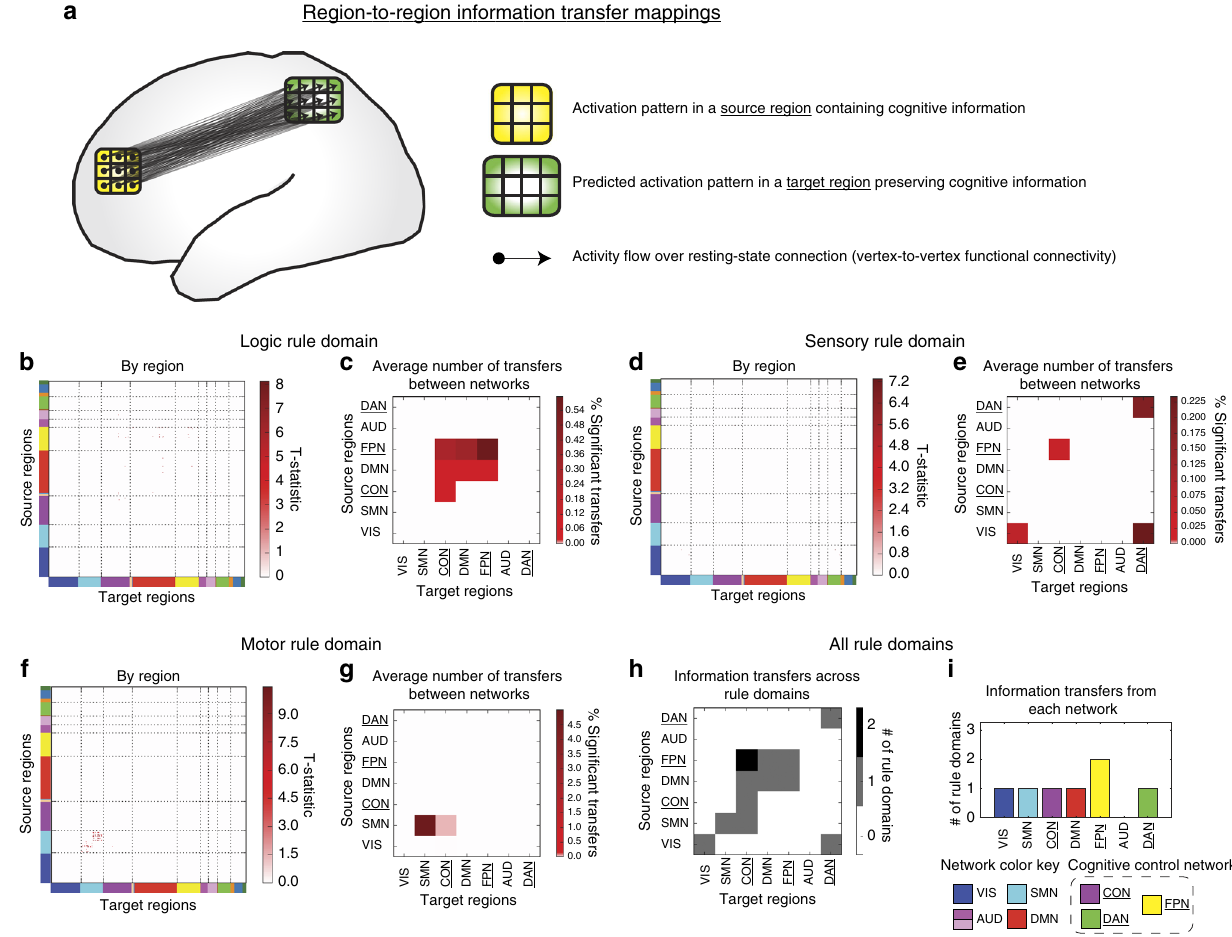
Fig. 6 Information transfer mappings between all pairs of regions. All reported results were statistically signi fi cant at p < 0.05 (FWE-corrected) (see Supplementary Fig. 6 for results with an FDR-corrected p < 0.05 threshold). a Region-to-region information transfer mapping used the vertex-level activation pattern within one brain region and the fi ne-grained region-to-region resting-state FC topology to predict the vertex-level activation pattern in another brain region. b Logic rule region-to-region information transfer mapping. c Average number of statistically signi fi cant region-to-region transfers by network af fi liations. To better visualize and assess how region-to-region transfer mappings may have been in fl uenced by underlying network organization, we computed the percent of statistically signi fi cant rule transfers for every network-to-network con fi guration (i.e., the percentage of region-to-region transfers from a network A to a network B). Note that visualizations for the full 14 network partition can be found in Supplementary Fig. 2. Cognitive control networks are underlined . Information transfer of logic rule information was distributed across frontal and parietal cortices. d , e Statistically signi fi cant sensory rule region-to-region information transfers. Region-to-region information transfers were substantially sparser for sensory rule mappings, but involved DAN and VIS regions. f , g Statistically signi fi cant motor rule region-to-region information transfers. Motor rule mappings were noticeably more localized within the motor network. h Statistically signi fi cant information transfers between regions grouped by network af fi liation across rule domains. Across the three rule domains ( c , e , and g ) we counted the number of rule domains information was transferred between networks. i We performed a similar analysis as in h , but counted the number of rule domains a network contained a region that transferred information (as a source region) across